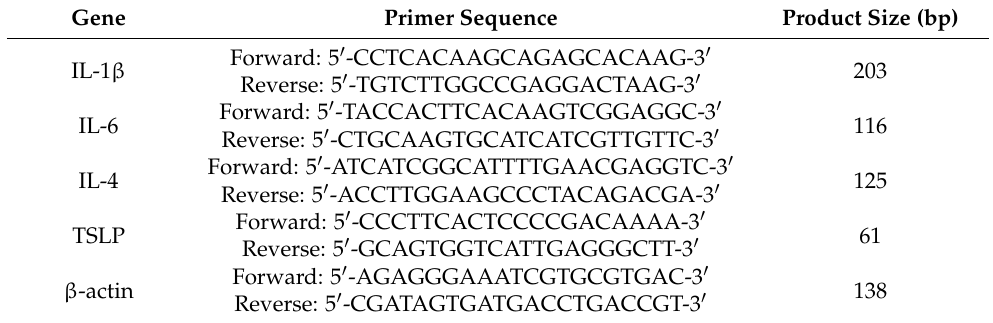
Table 1. Sequences of qRT-PCR